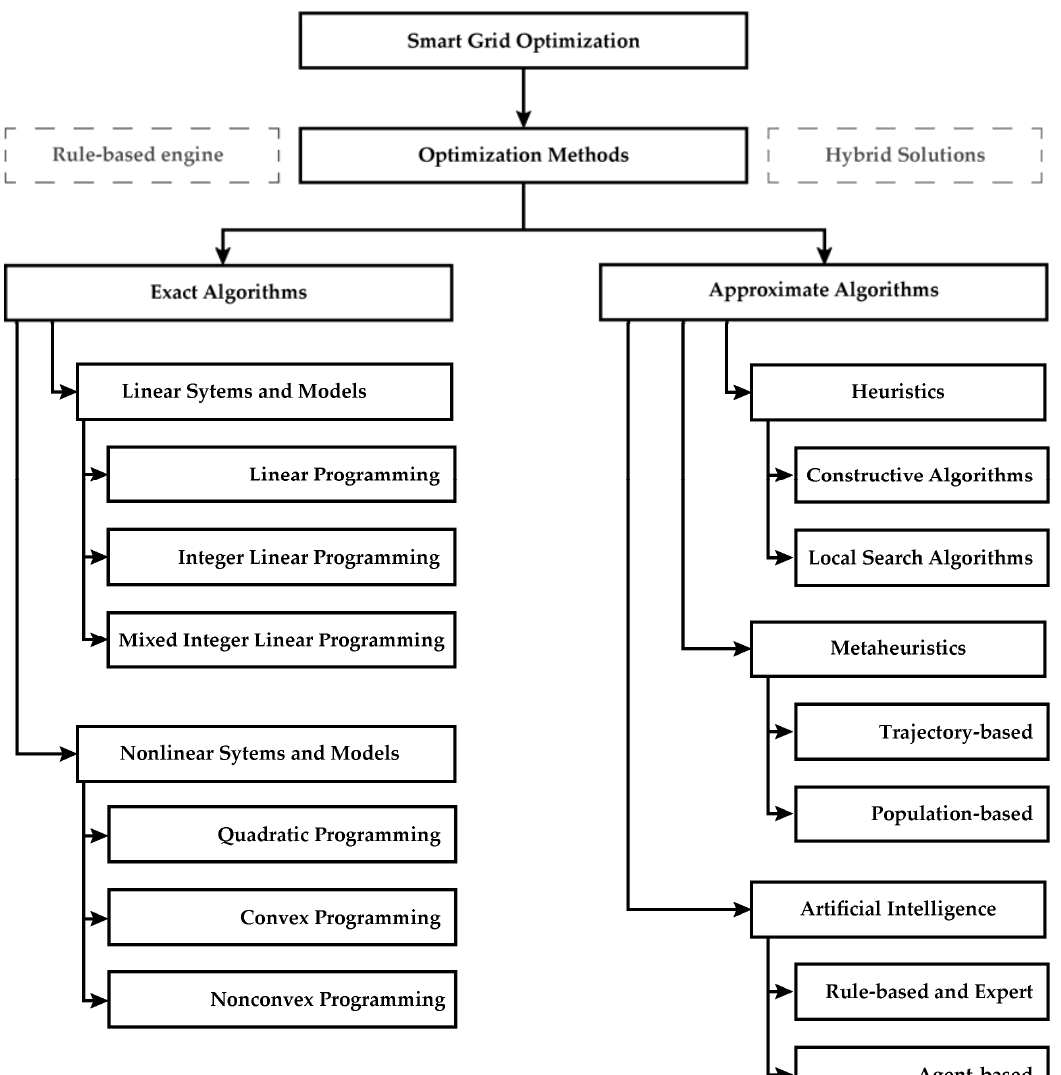
Figure 2. Optimization methods for Smart Grid applications.